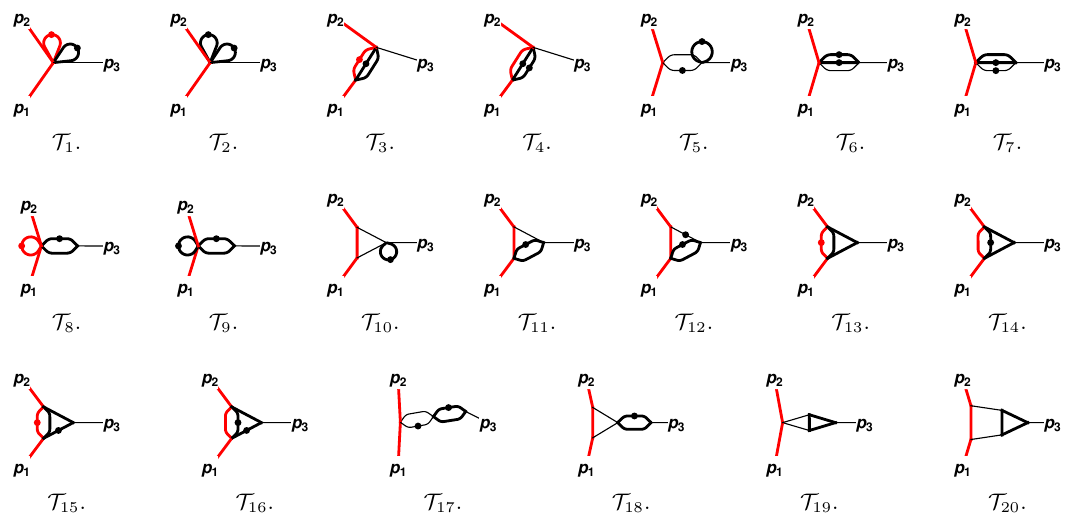
Figure 9. Master integrals T 1 ... 20 for the leading-order bottom Yukawa contributions to the Higgs boson decay into charm quarks. Thin black lines represent massless propagators, while thick black lines and red lines represent massive propagators with mass m b or m c respectively. Dots represent additional powers of the